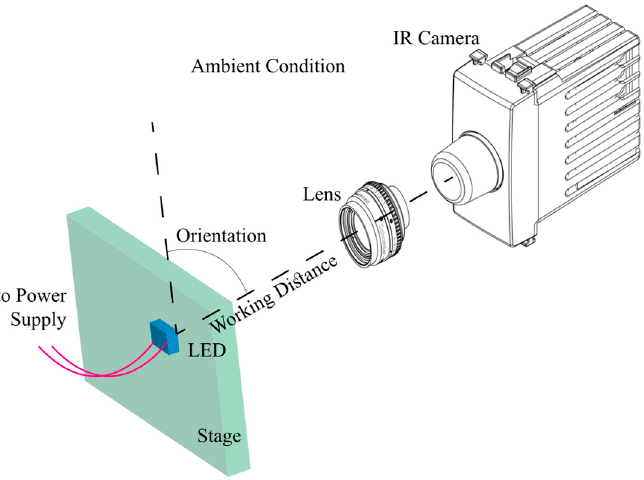
Figure 4. Schematic of the generally used experimental arrangement and apparatus of the IR thermography measurements. Spatial resolution, spectral and sensitivity range, and correct emissivity calibration are all important factors for measurement accuracy.